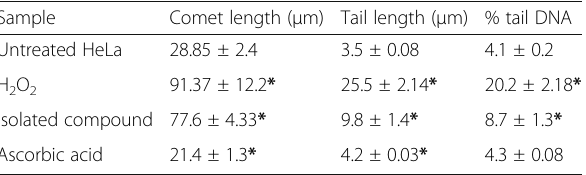
Table 2 Level of DNA damage in normal, control, and phenolic compound isolated from Terminalia chebula on HeLa cell